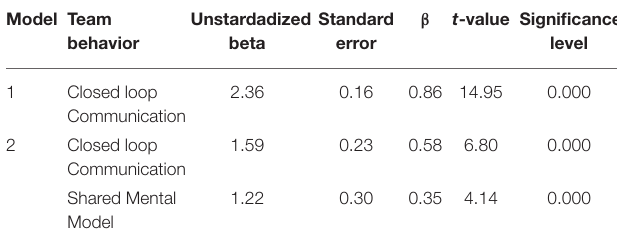
TABLE 7 | Hierarchical regression analyses of decision-making behavior regressed on closed loop communication and shared mental